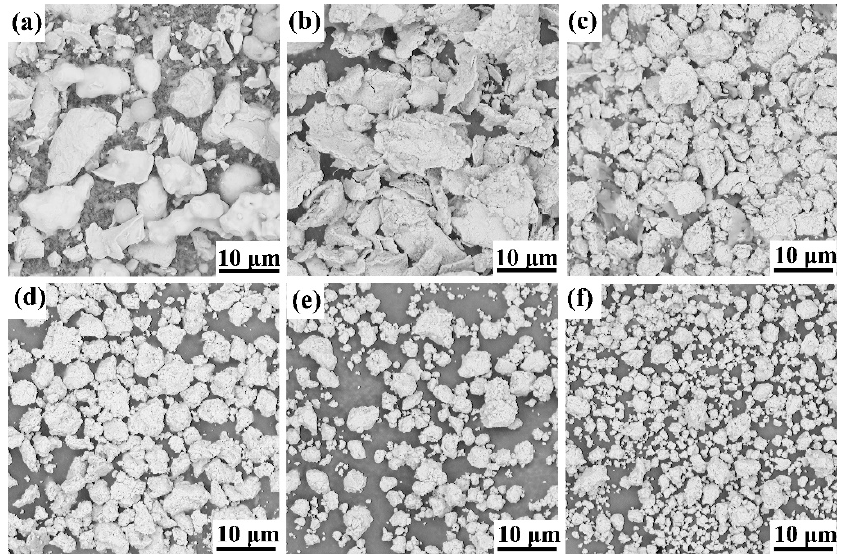
Figure 1. SEM images of 25 vol.%TiB 2 /Fe-15Cr-10Mn-5Al composite powder after ( a ) 0 h, ( b ) 5 h, ( c ) 10 h, ( d ) 20 h, ( e ) 40 h, and ( f ) 60 h of ball milling.